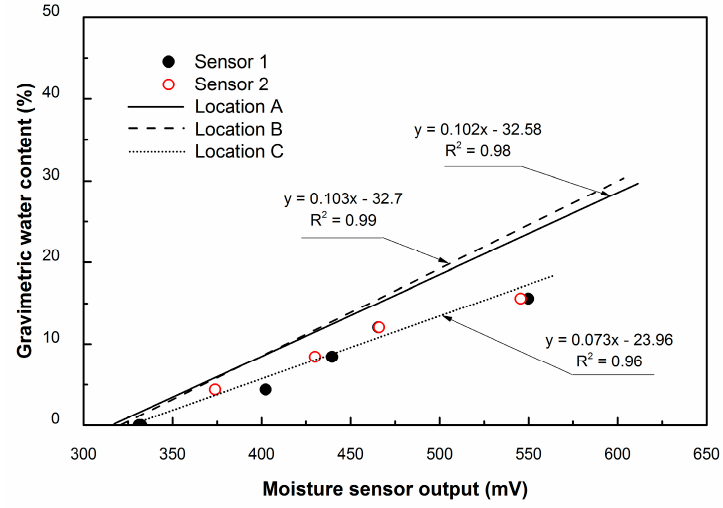
Figure 5. Calibrated results of gravimetric water content at three locations (A, B, and C) using two sensors.